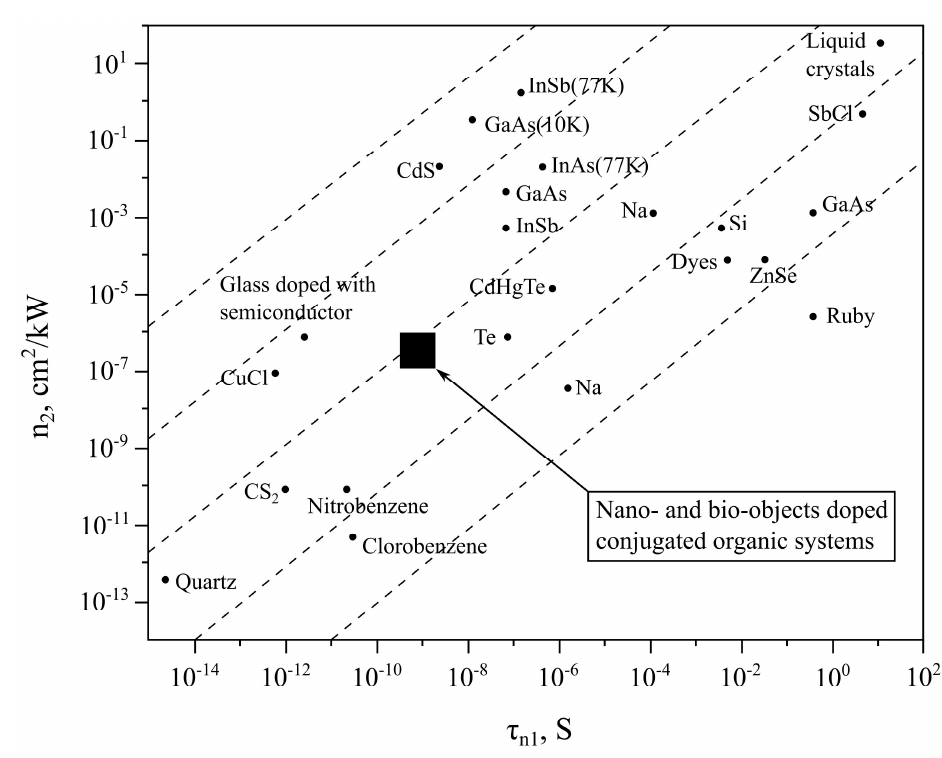
Figure 3. The place of the nano- and bio-objects doped materials among other classical systems with essential refractive features.